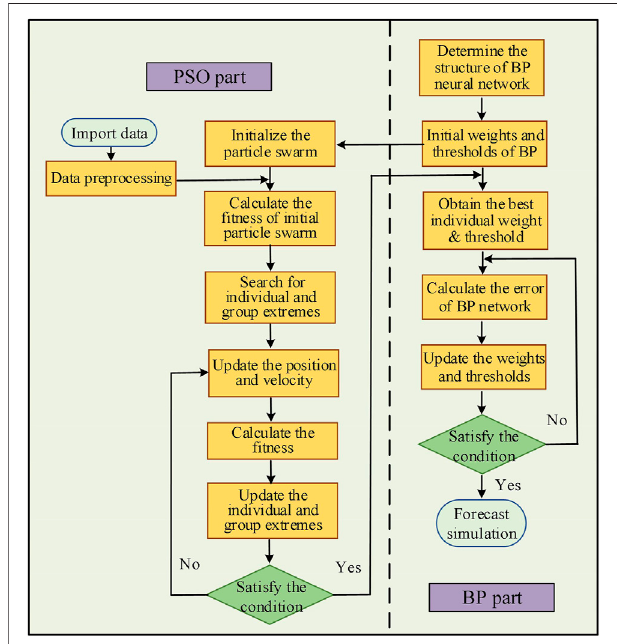
FIGURE 3 | Flowchart of the PSO-BP algorithm.